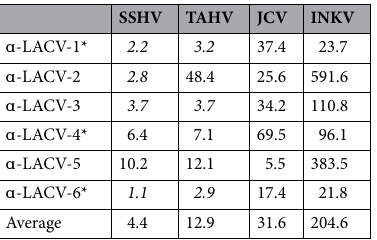
Table 3. ND50 fold difference of ɑ -LACV plasma between heterologous viruses vs. homologous LACV. *Homologous ND50 > 6250, but 6250 highest dilution tested and value used. Italics = < fourfold difference.